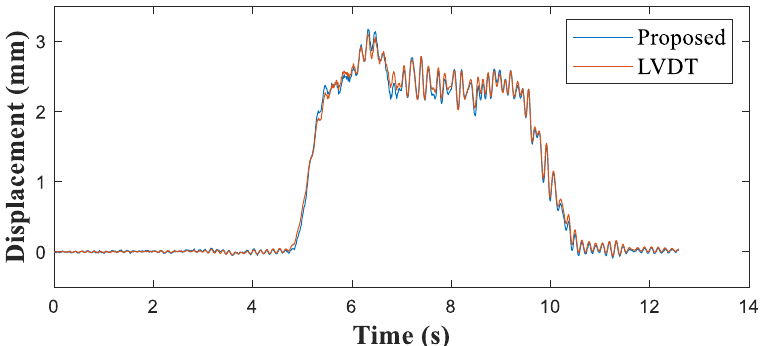
Figure 9. Comparison of structural displacements at the mid-span point of the Keukrak Bridge. Table 3. Comparison of displacement measurements on the Keukrak Bridge .